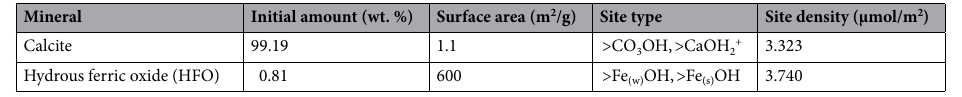
Table 2. Composition, surface areas, type of surface types, and site densities used in the